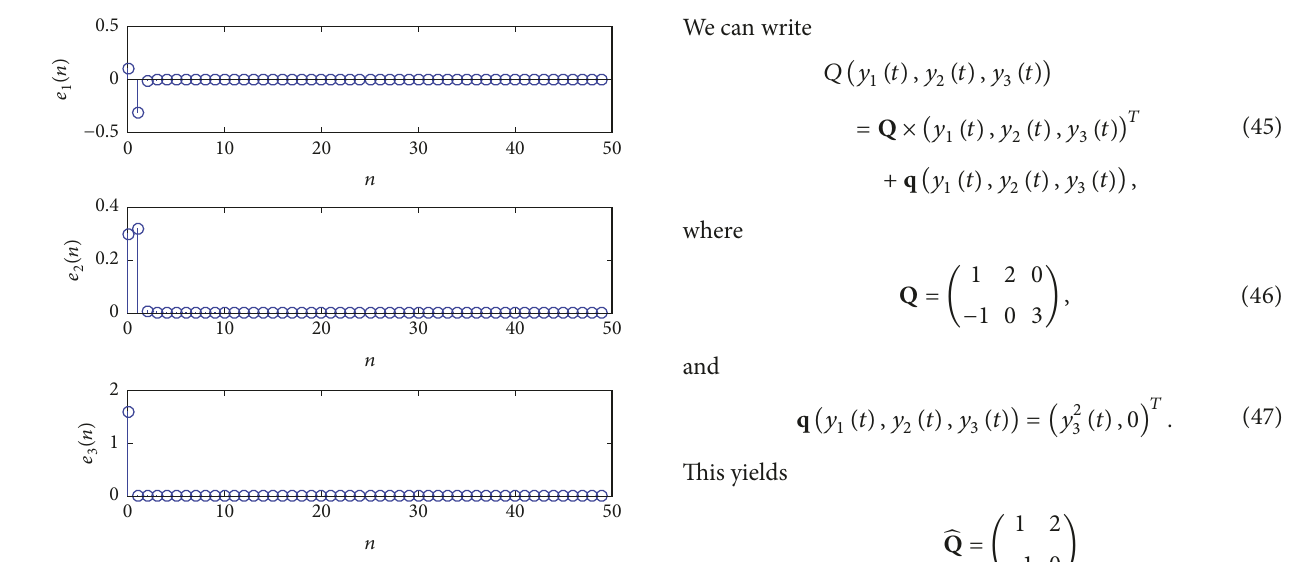
Figure 3: The evolution of errors over time for Case